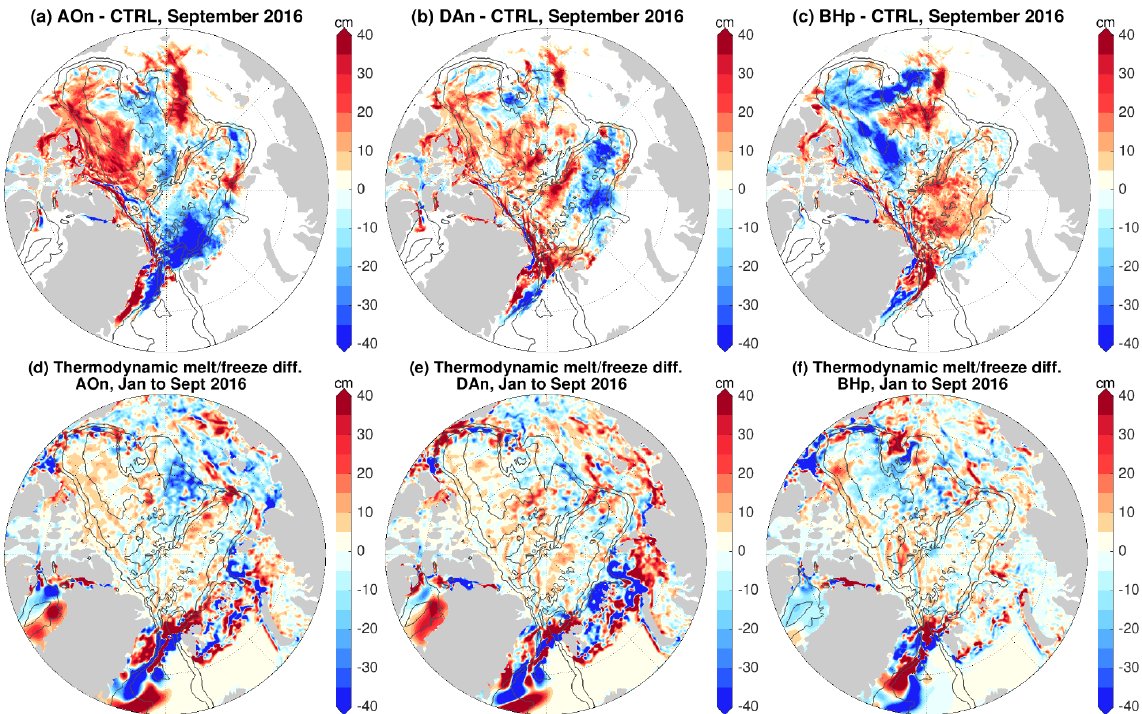
Figure 10. (a) Anomaly of sea ice thickness in September 2016 and (d) anomaly of the change in sea ice thickness from January to September in 2016 due to sea ice thermodynamics in the experiment with an initial ocean spun up with the negative phase of Arctic Oscillation (AO) perturbation beforehand. The first model year of the sensitivity simulations is 2016. The anomalies are referenced to the control run. (b, e) The same as (a, d) , but for the experiment with an initial ocean spun up with the negative phase of Dipole Anomaly (DA) perturbation. (c, f) The same as (a, d) , but for the experiment with an initial ocean spun up with the positive phase of Beaufort High (BH) perturbation. The black contour lines indicate the 500, 2000 and 3500m